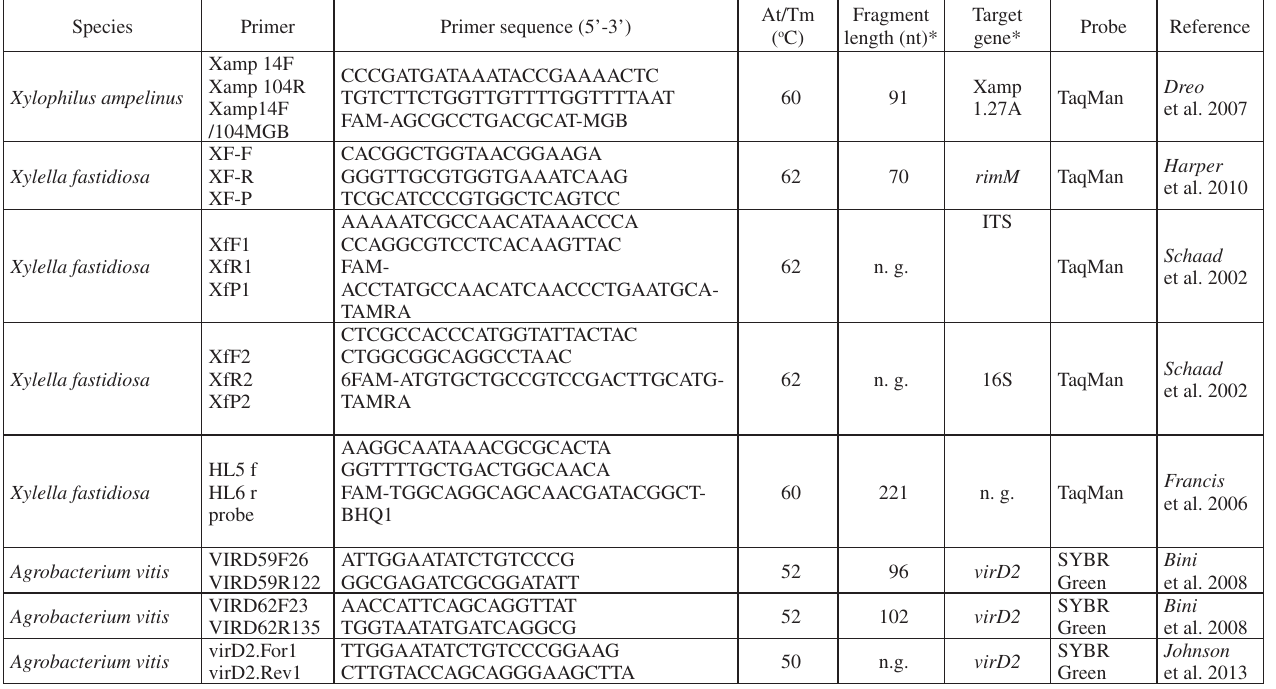
Table 4. Bacterium specific primers